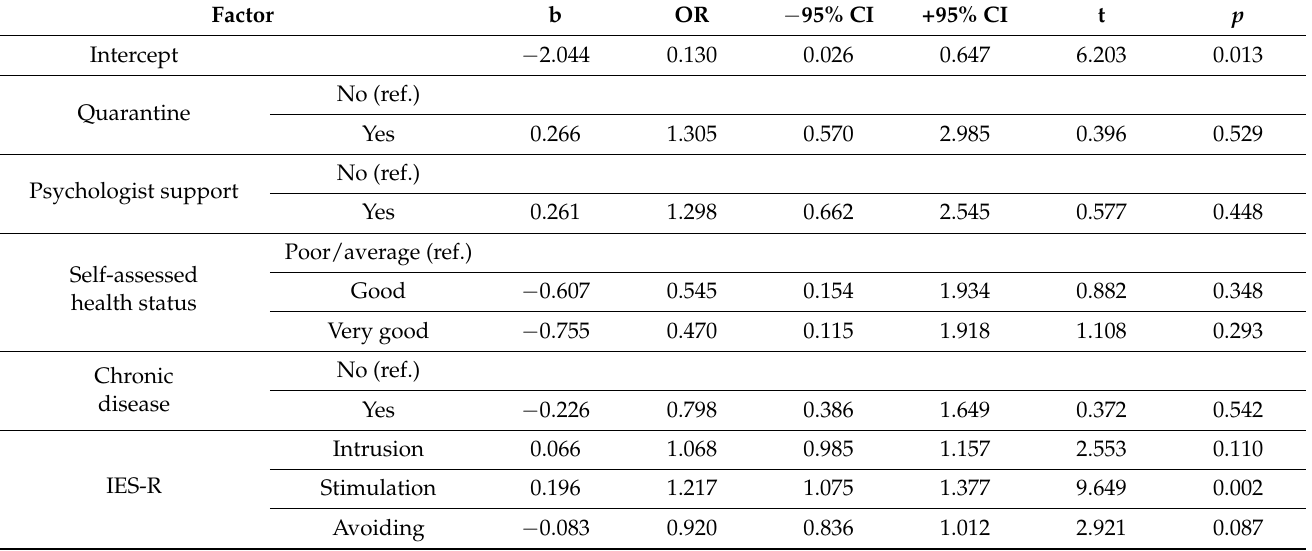
Table 2. The influence of the self-assessment of health, quarantine, psychological support, presence of chronic diseases and dimensions according to the Impact of Event Scale—Revised (IES-R) on the occurrence of insomnia according to the